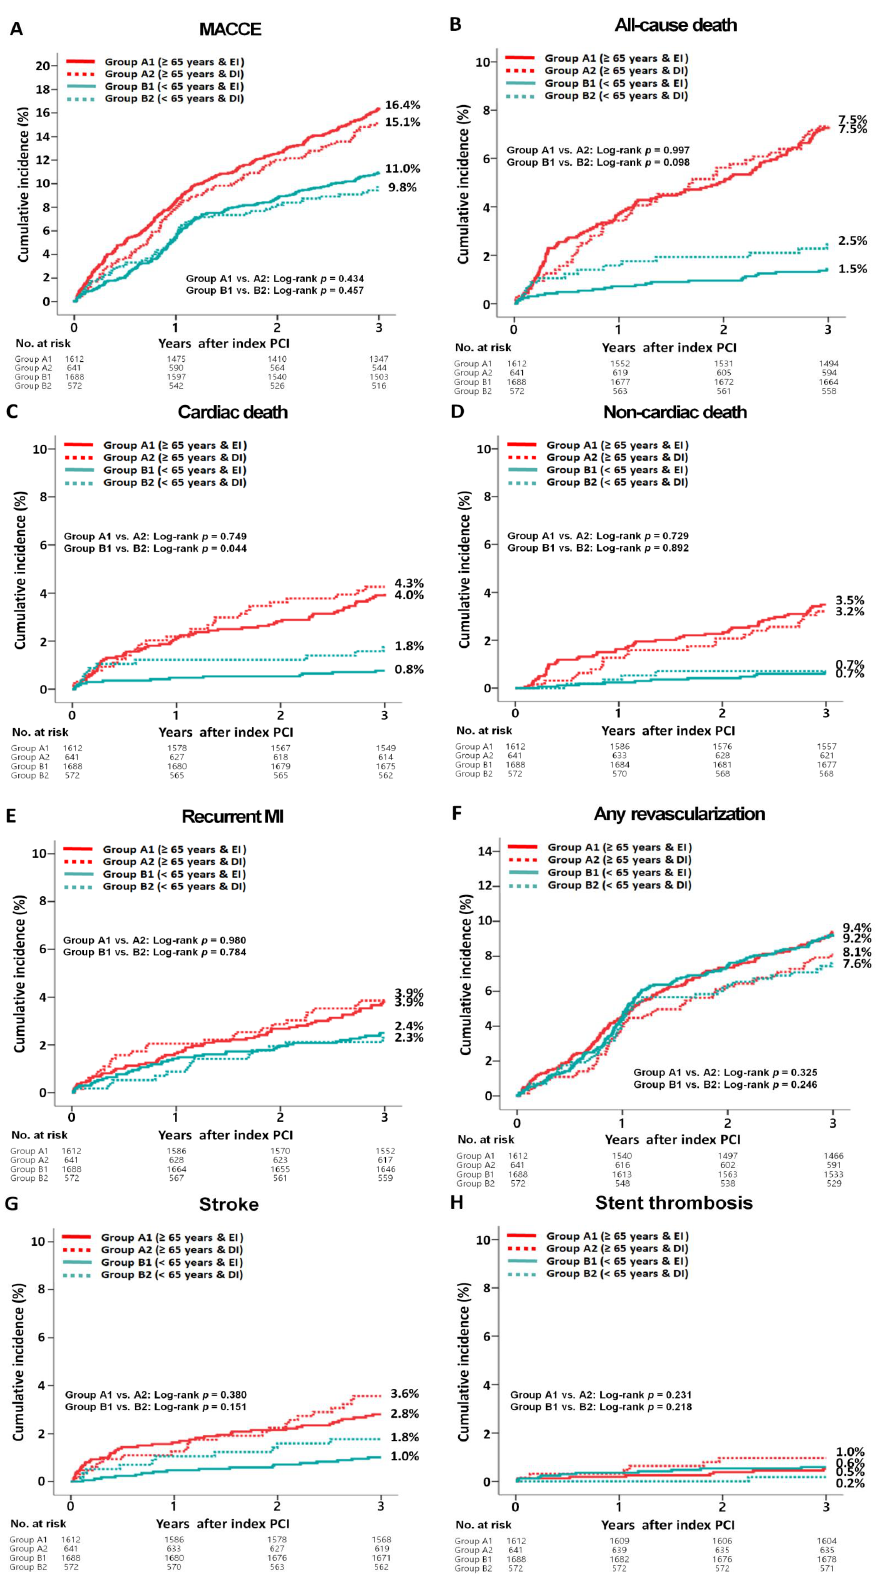
Figure 2. Kaplan-Meier curved analysis for MACCE ( A ), all-cause death ( B ), cardiac death ( C ), non- cardiac death ( D ), recurrent MI ( E ), any repeat revascularization ( F ), stroke ( G ), and stent throm- bosis ( H ). MACCE, major adverse cardiac and cerebrovascular events; MI, myocardial infarction; PCI, percutaneous coronary intervention; EI, early invasive; DI, delayed invasive. For further assessment of major clinical outcomes between the EI and DI groups of groups A and B, we compared these major clinical outcomes by limiting the study popu- lation to patients with complex lesions (Table 3). The number of patients with complex lesions in each group was >40% (group A1, 49.6%; group A2, 55.5%; group B1, 40.9%; group B2, 46.5%) (Figure 3). The MACCE rates were similar between the EI and DI groups (group A1 vs. group A2; aHR, 1.149; 95% CI, 0.843–1.564; p = 0.379; group B1 vs. group B2; aHR, 1.136; 95% CI, 0.754–1.713; p = 0.542) (Table 3). The ST (definite or probable) rates were also similar between the EI and DI groups (group A1 vs. group A2; aHR, 3.777; 95% CI, 0.673–116.94; p = 0.139; group B1 vs. group B2; aHR, 1.140; 95% CI, 0.030–43.82; p = 0.944, Table 3). Additionally, all-cause death, CD, non-CD, re-MI, any repeat revasculari- zation, and stroke rates were not significantly different between the EI and DI groups after adjustment (Table 3). Figure 4 shows the subgroup analysis for MACCE in groups A and B. The results of the subgroup analysis using the Cox logistic regression model revealed